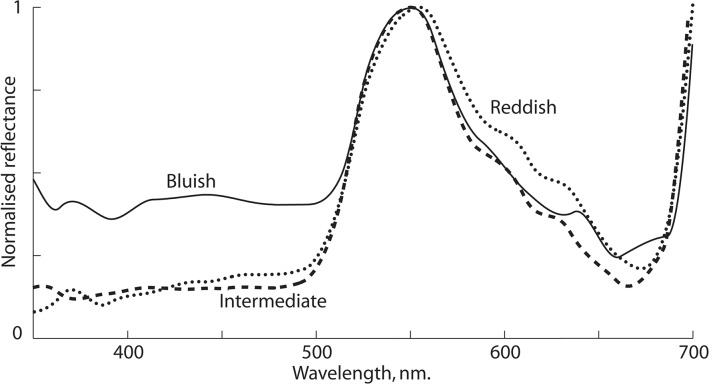
Reflectance spectra of three cabbage leaves of contrasting colour, normalised to the chlorophyll peak close to 550nm.
Solid line: a bluish leaf with relatively high reflectance in the range 400-500nm, perhaps due to waxy epidermis; Dashed line: a leaf of intermediate coloration dominated by chlorophyll and probably appearing green to the human eye; Dotted line: a reddish leaf with relatively high reflectance above 550nm due the presence of long wavelength reflecting pigments. Spectra were recorded as described in the text, and then smoothed by fitting with a piecewise cubic function with 30 equal sections spanning the interval 300nm– 800nm was fitted to the spectra by minimising the total square deviation.